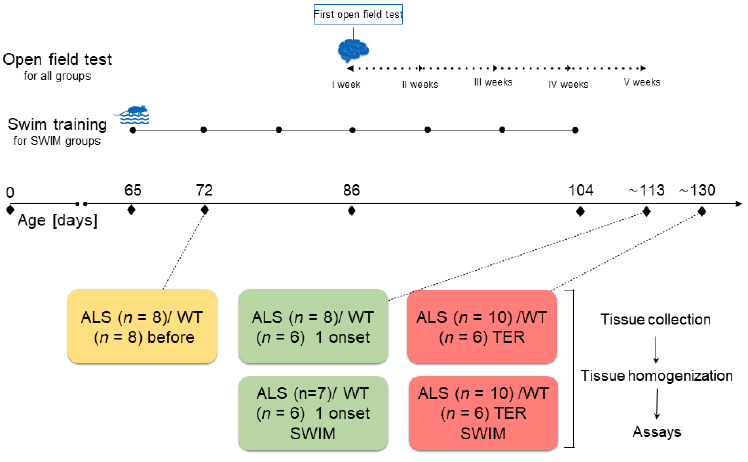
Figure 6. Study Figure 6. Study design.